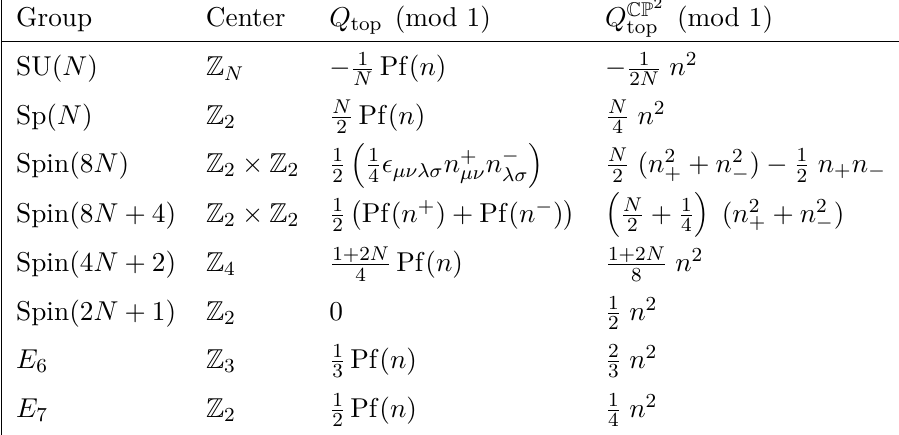
Table 5 . Summary of the topological charges mod1 on T 4 for all gauge groups with non-trivial center, derived in section B.2. The third column shows the result of our calculation of the topo- logical charge on the non-spin manifold CP 2 , where n, n ± are the corresponding integer twists, for derivation and explanation, see appendix